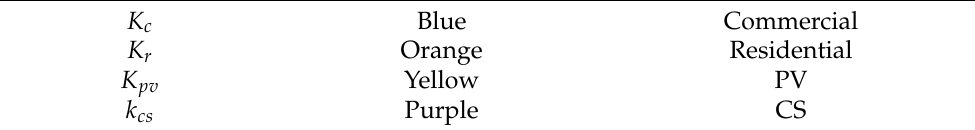
Table 12. Load coefficients